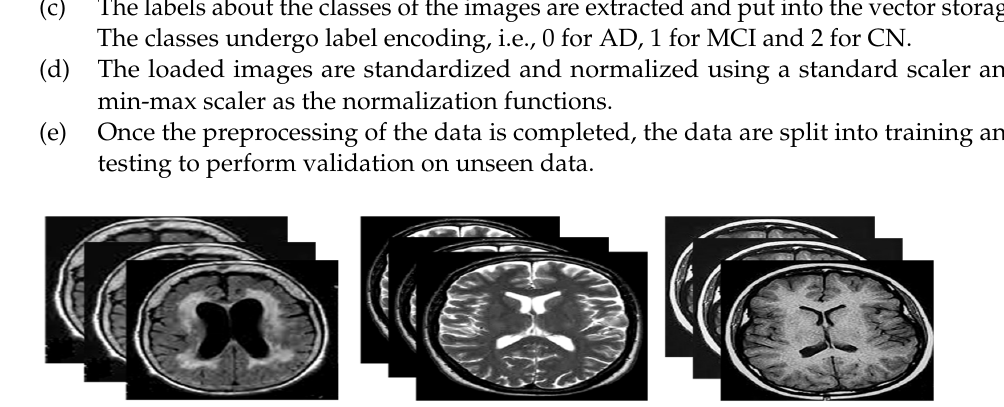
tive Impairment and ( c ) Control Normal. Impairment and ( c ) Control Normal.